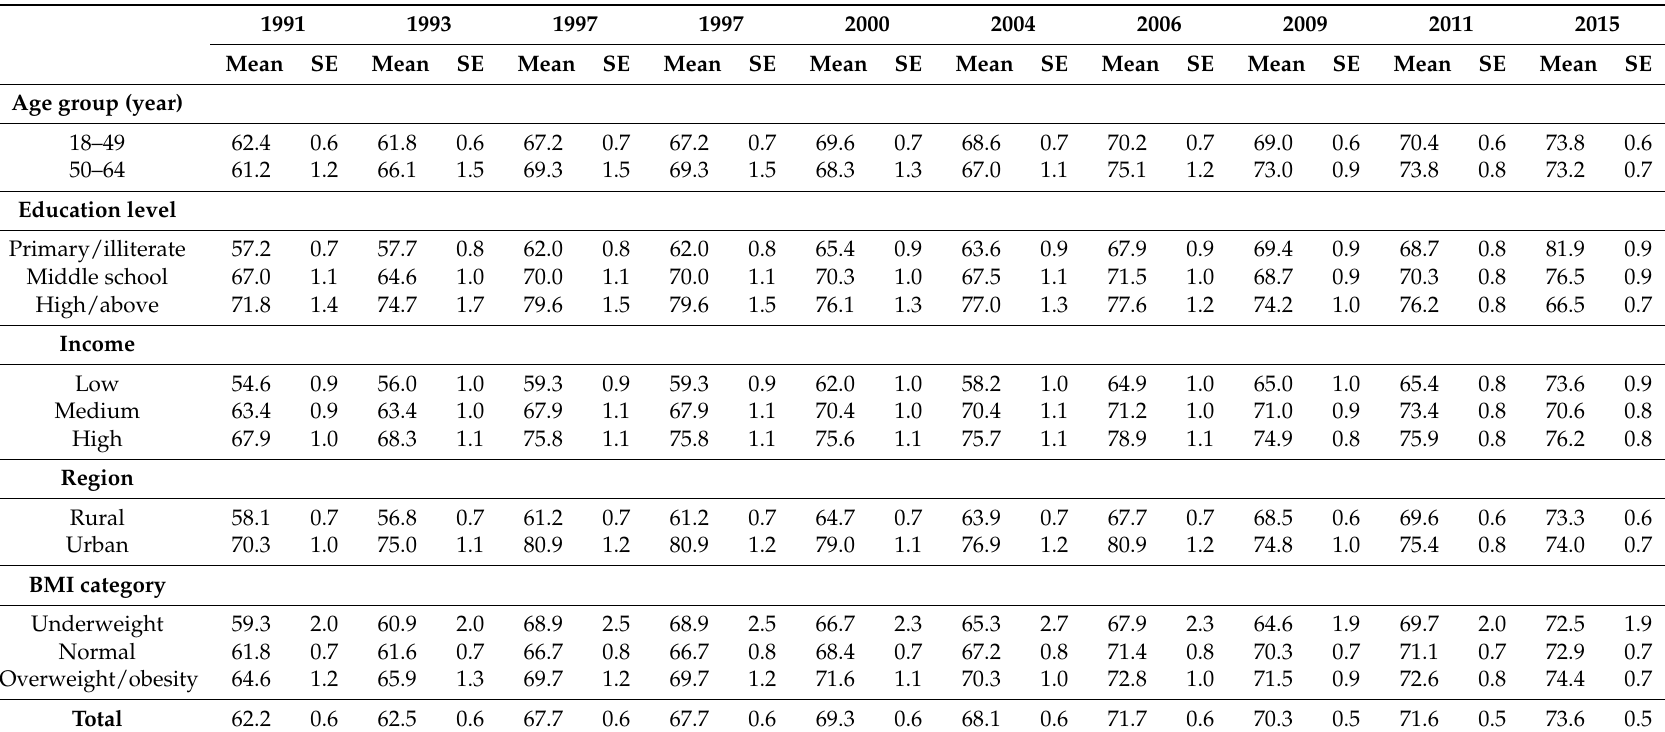
Table 3. Daily fat intake (g), by age, education, income and geographical region, in Chinese women from 1991 to 2015 1,2